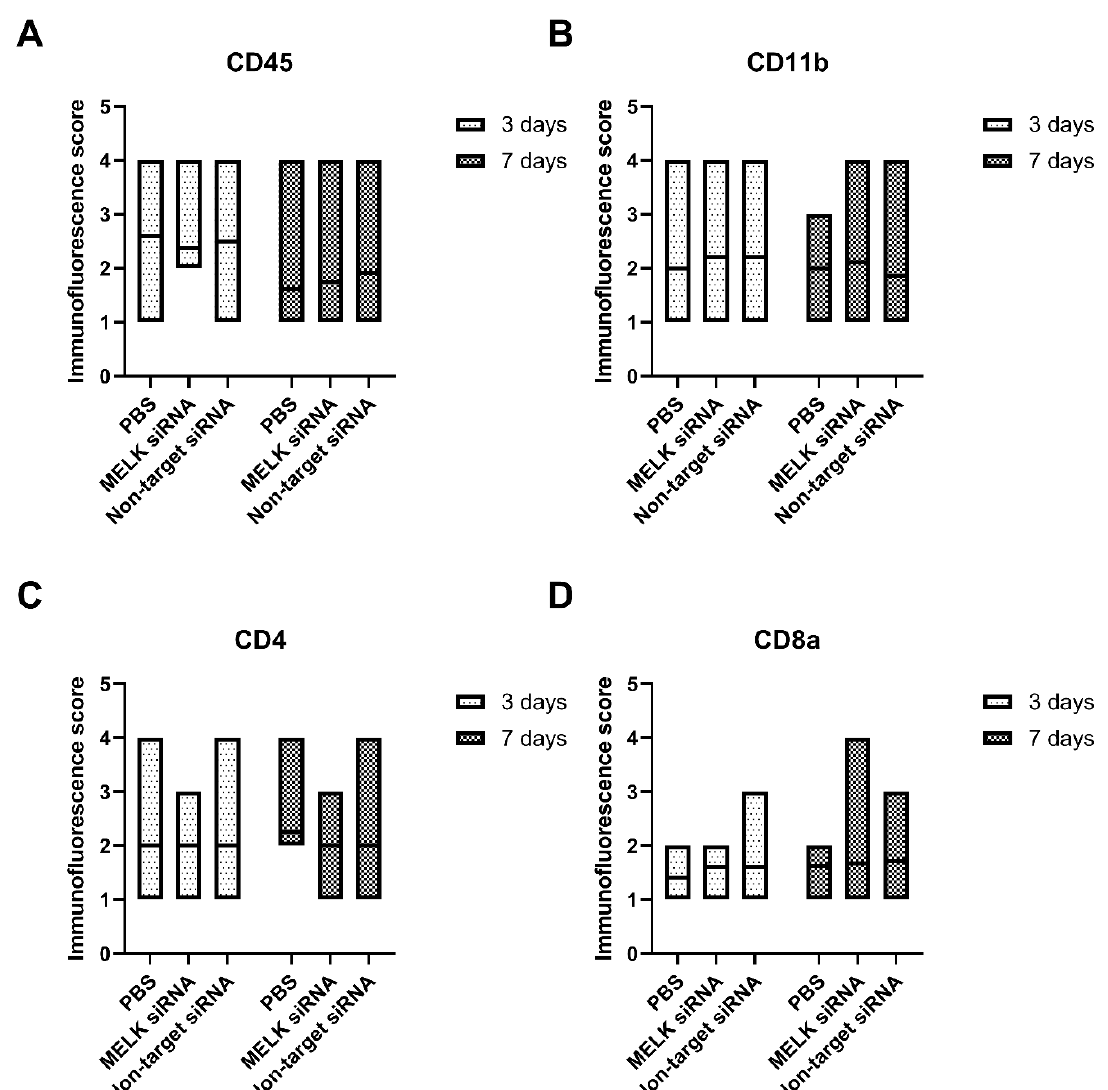
Figure 6. Immunofluorescence staining results of wounds 3 and 7 days after treatment with PBS, MELK siRNA, and non-target. ( A ) Nucleated hematopoietic cell infiltration measured as immunofluorescence score of CD45 expression. ( B ) Myeloid cell infiltration measured as immunofluorescence score of CD11b expression. ( C ) Helper T cells infiltration measured as immunofluorescence score of CD4 expression. ( D ) Cytotoxic T cells infiltration measured as immunofluorescence score of CD8a expression n ≥ 6. Results are presented as the mean ± range.